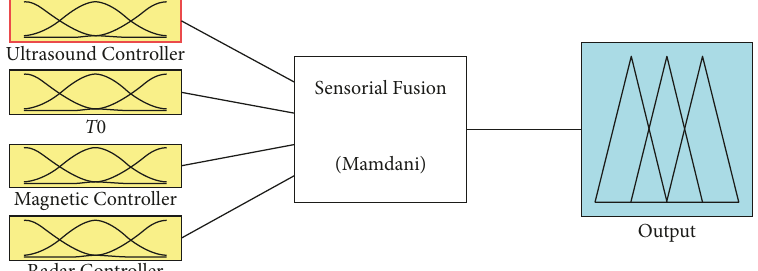
Figure 5: Structure of the fuzzy inference